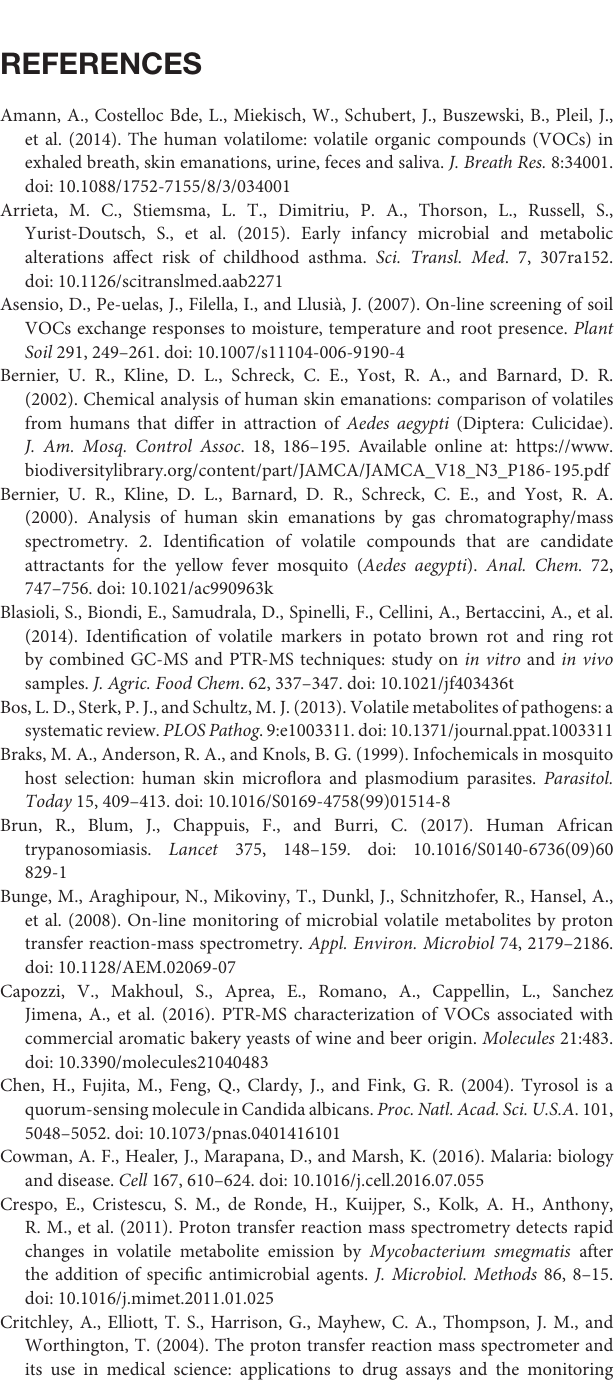
distinguish from 2-nonanone curve given similar retention times. (B) 30 ◦ C incubation, (C) 37 ◦ C incubation. Shapes are filled when confirmed by co-elution with chemical standards, hollow when identified only through library matching. The compounds are labeled as follows: • = 1-nonene; ◦ = 2-heptanone; (cid:3) = 2-heptanol; N = 1-undecene; (cid:4) = 2-nonanone; (cid:7) = 2-undecanone; H = 2-undecanol; ♦ = 2-tridecanone. Peaks labeled as X are identified as siloxane contaminants. Table S1 | Custom library for putative compound